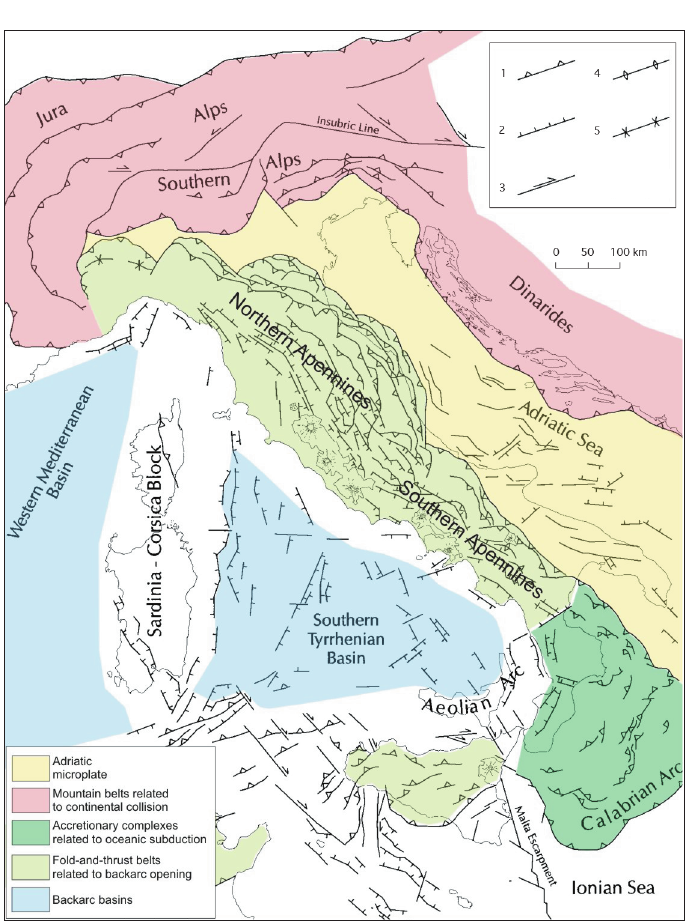
Fig. 1.1. Simplified structural map of the Central Mediterranean region showing the main tectonic domains (af- ter Meletti et al ., 2000): 1 – thrusts; 2 – normal faults; 3 – strike slip faults; 4 – Pliocene-Quaternary anticlines; 5 – Pliocene-Quaternary